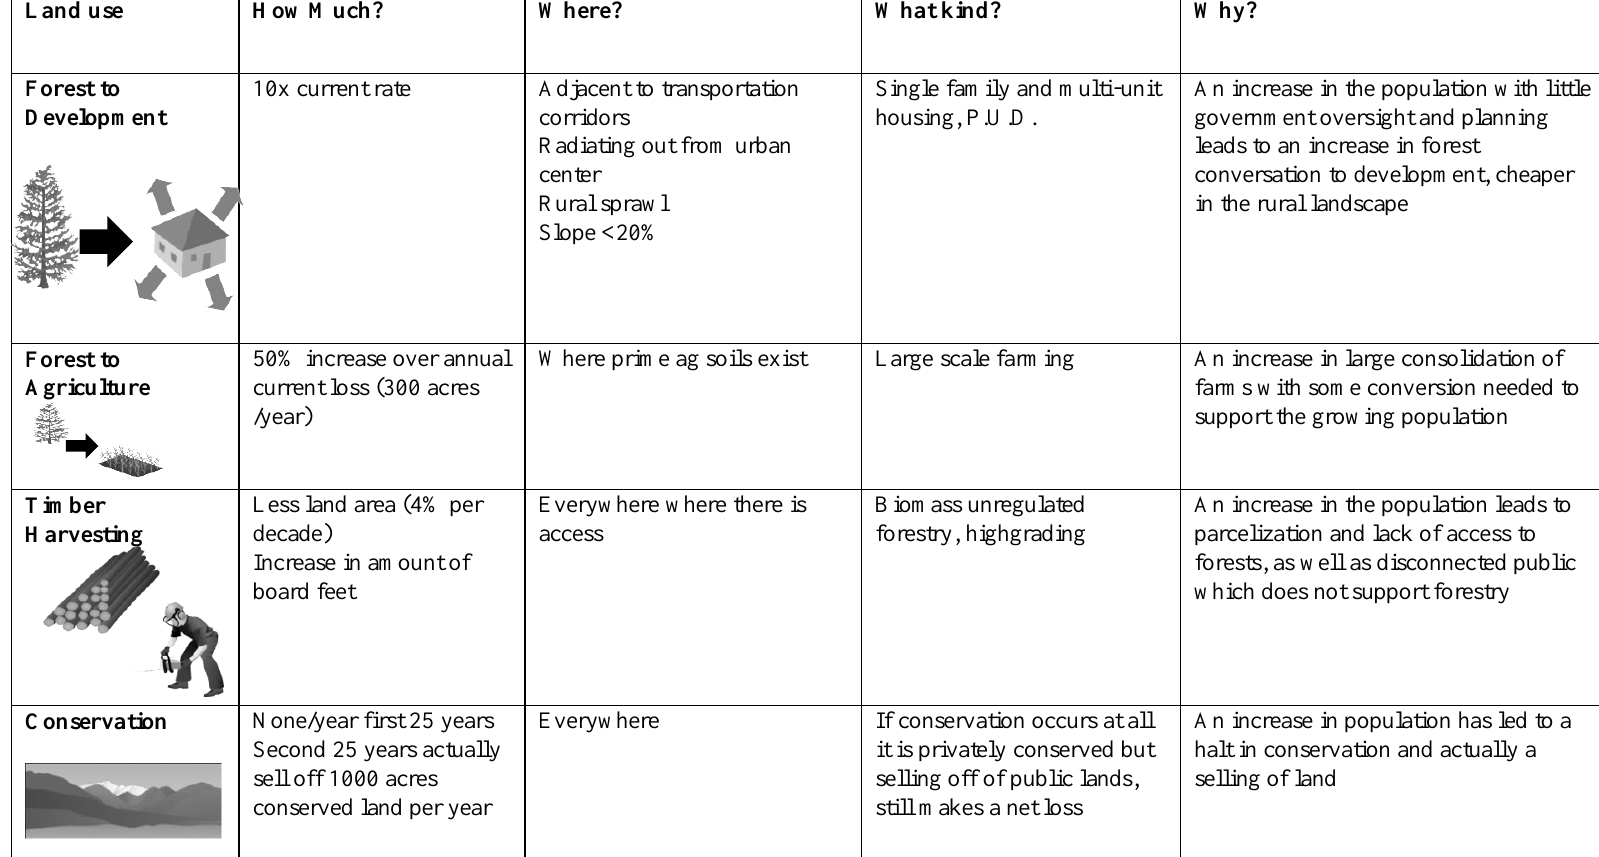
Table A2.3. Scenario 3: Darkness on the Edge of